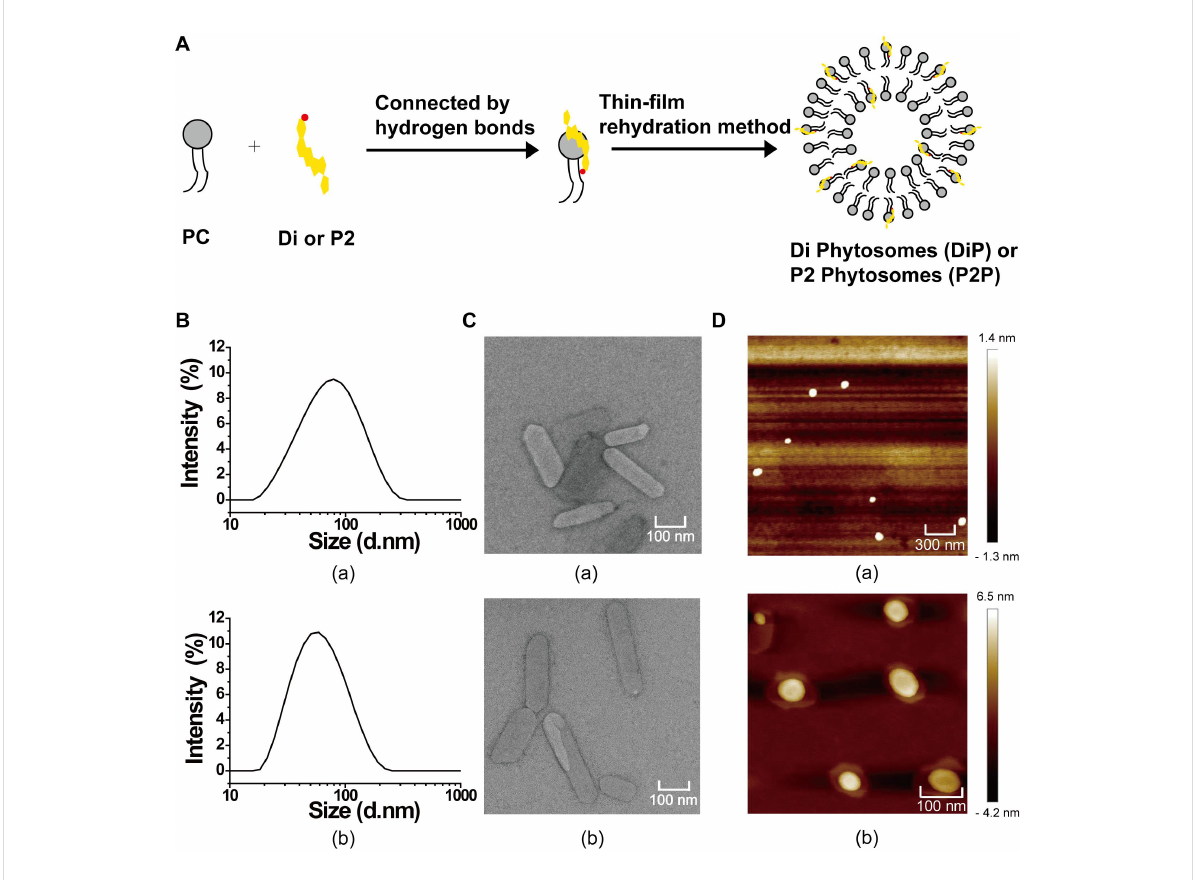
Figure 3: Preparation and characterization of Di phytosomes (DiP) and P2 phytosomes (P2P). (A) Schematic illustration of the preparation processes for DiP and P2P. (B) DLS measurements of DiP (a) and P2P (b). (C) TEM images of DiP (a) and P2P (b). (D) AFM images of DiP (a) and P2P (b).